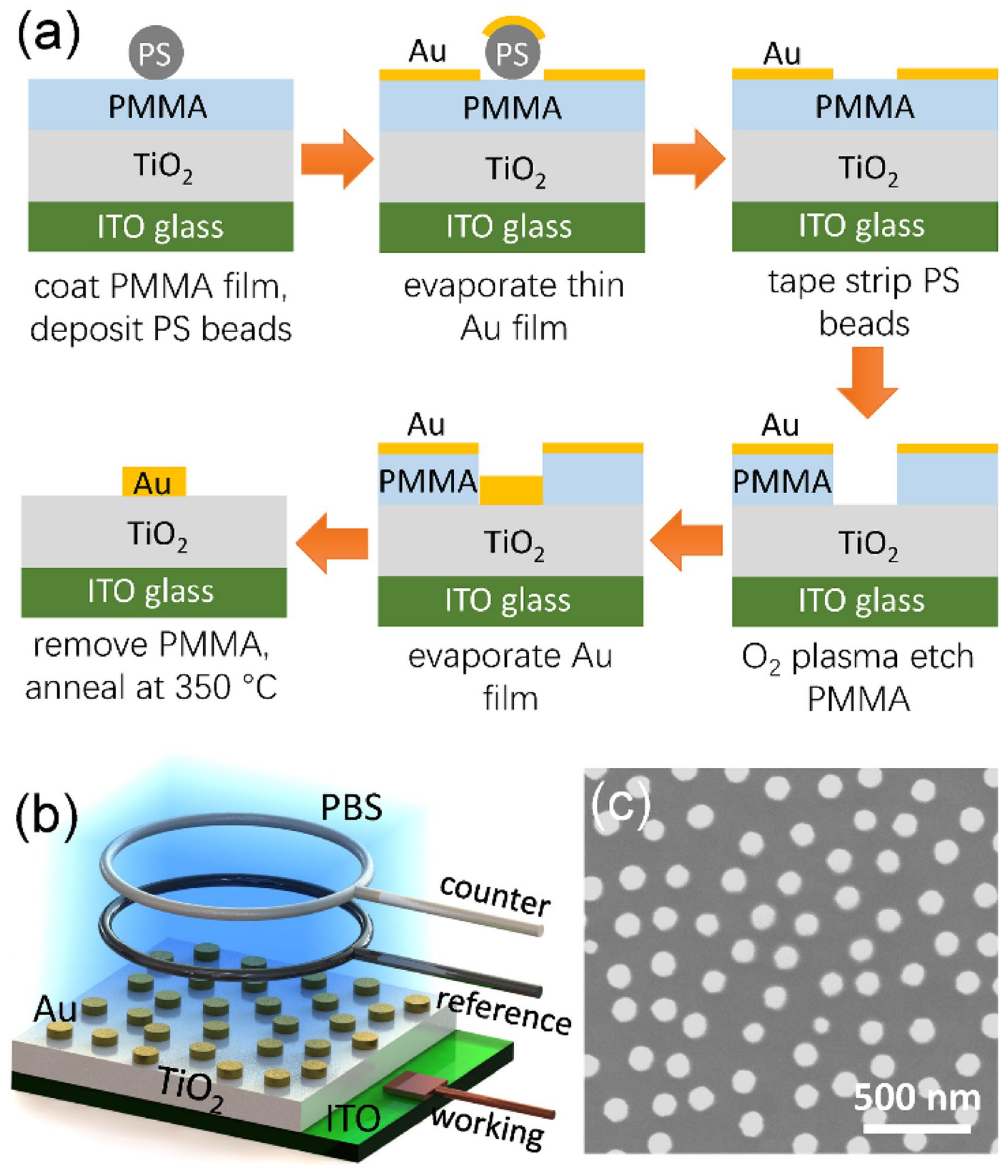
electrochemical cell. ( c ) SEM image of AT sample with 100 nm nanodisk